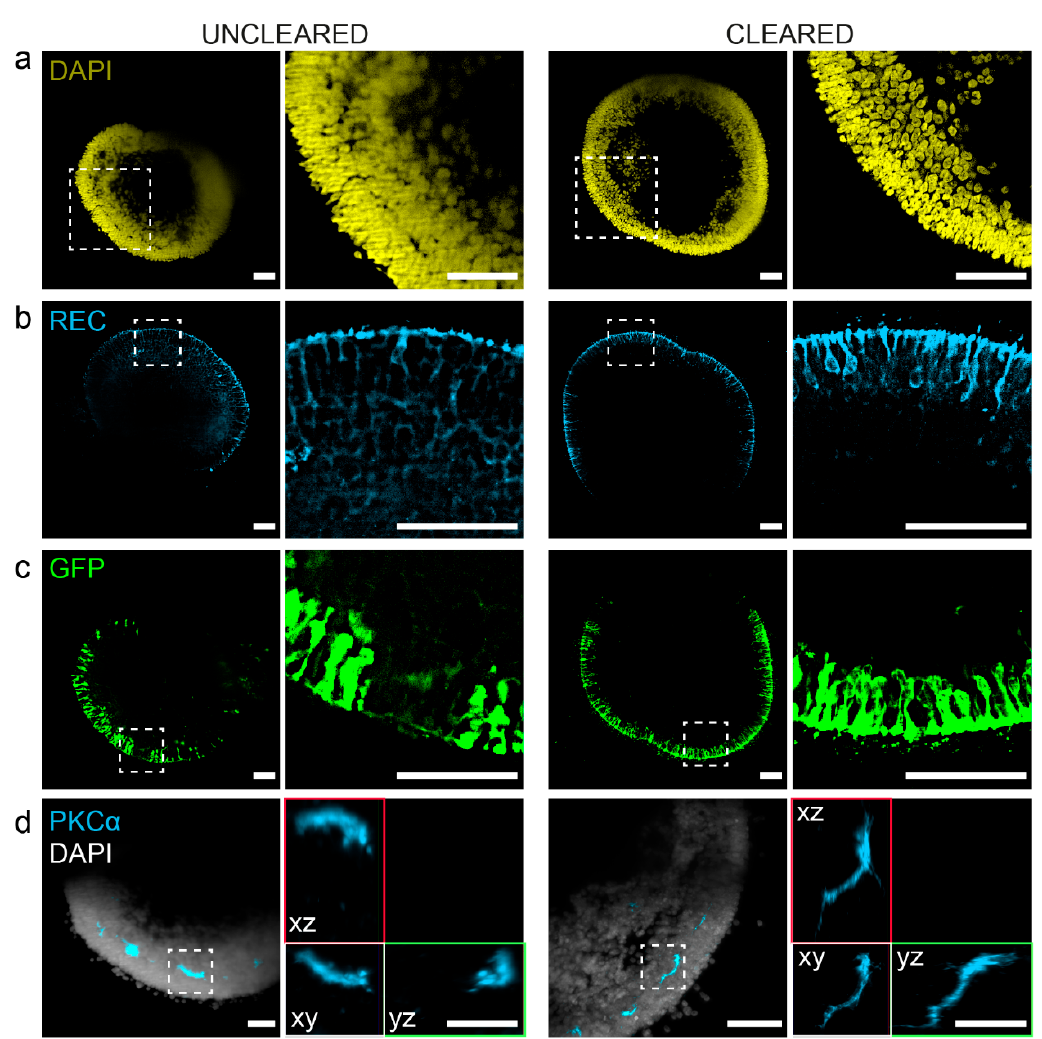
Figure 2. PACT greatly improves retinal organoid immunocytochemistry and high-resolution imaging. Retinal organoids were immunostained and imaged by light sheet microscopy. Single planes were selected from an acquired image stack to visualize differences between uncleared (left panel) and cleared (right panel) retinal organoids. Each panel contains an overview (left image) and magnified cutout (right image). Organoids were labeled as followed: ( a ) day 182 retinal organoids were labeled with DAPI (4 ′ ,6-Diamidin-2-phenylindol, nuclei staining, yellow). Second and forth image show a magnified area as indicated in the first and third image, respectively. ( b ) Day 182 retinal organoids were stained for Recoverin (pan-photoreceptor marker). Second and forth image show a magnified area as indicated in the first and third image, respectively. ( c ) Day 182 retinal organoids were previously transfected with a lentiviral vector labeling photoreceptor cells (pJG-IRPB-eGFP). Cleared or uncleared retinal organoids were additionally stained by a GFP-antibody. ( d ) Day 290 retinal organoids were stained for PKC α (bipolar cell marker, light blue) and DAPI (nuclei, white). Second and forth image show xy-, xz-, and yz-plane views of a magnified bipolar cell. Scale bars: ( a – c ) 100 µm, ( d ) 50 µm.